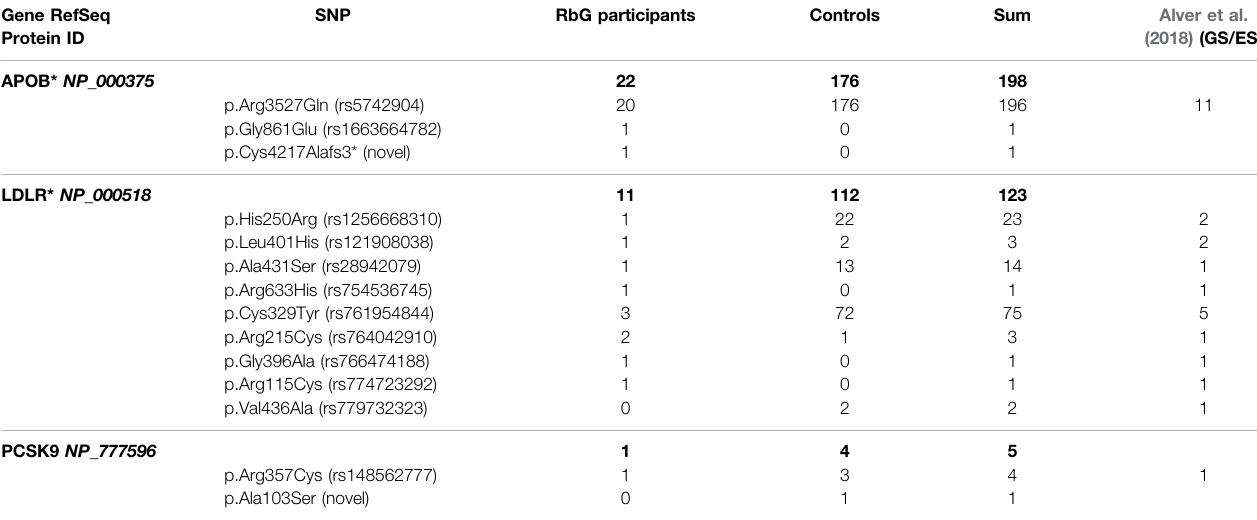
TABLE 1 | FH-associated genetic variants detected in the follow-up cohort. Participants with LDLR p.Val436Ala (rs779732323) and PCSK9 p.Ala103Ser (novel) were assigned to the control group because they declined visitation offered by Alver et al. (2018) in 2016 – 2018. *One individual had both APOB p.Arg3527Gln (rs5742904) and LDLR p.His250Arg (rs1256668310) variants. SNV, single nucleotide variant; rs, dbSNP reference number; RbG, recall by genotype; GS, genome sequencing; ES, exome